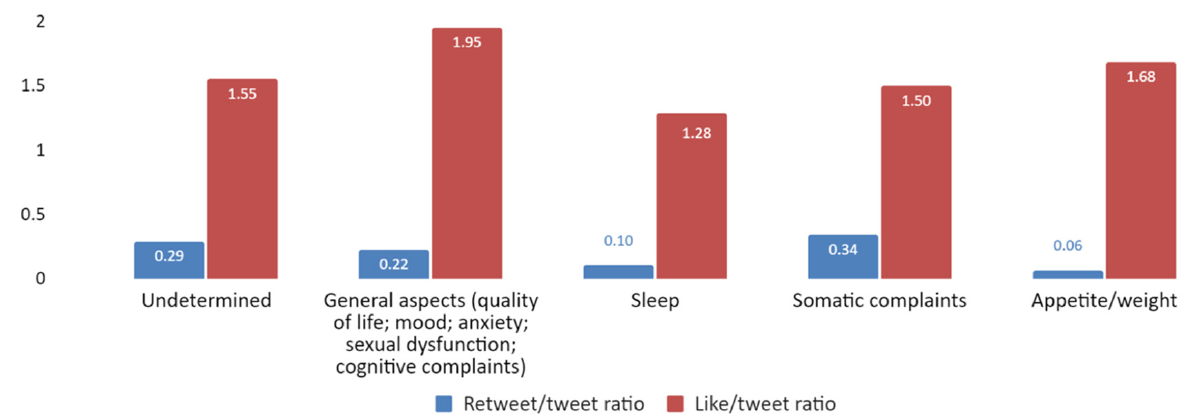
Figure 6. Retweet and like ratio ( Y -axis) by area of clinical interest ( X -axis). In addition, we studied the likelihood of a non-medical tweet being liked or retweeted.